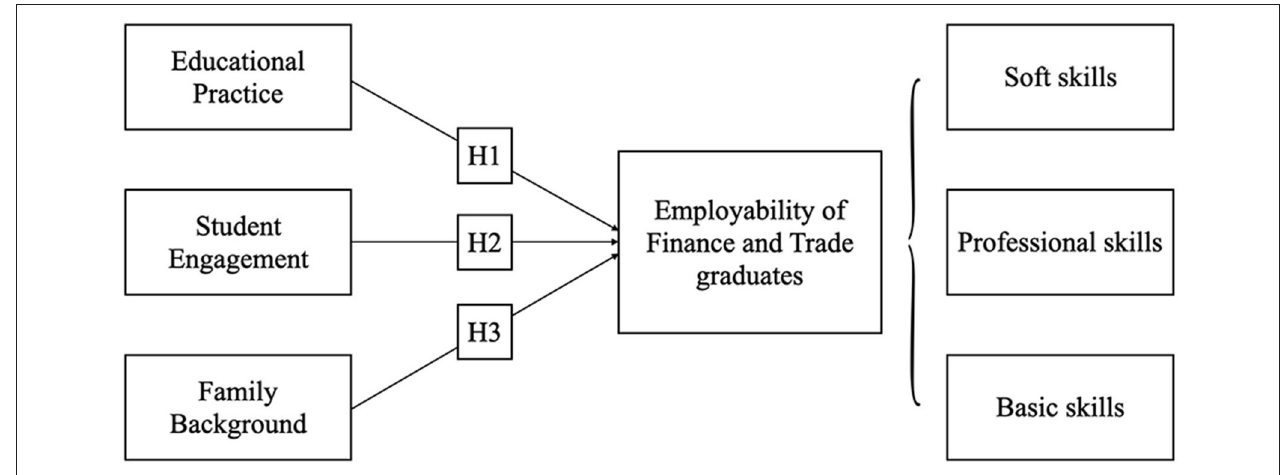
FIGURE 1 | Research